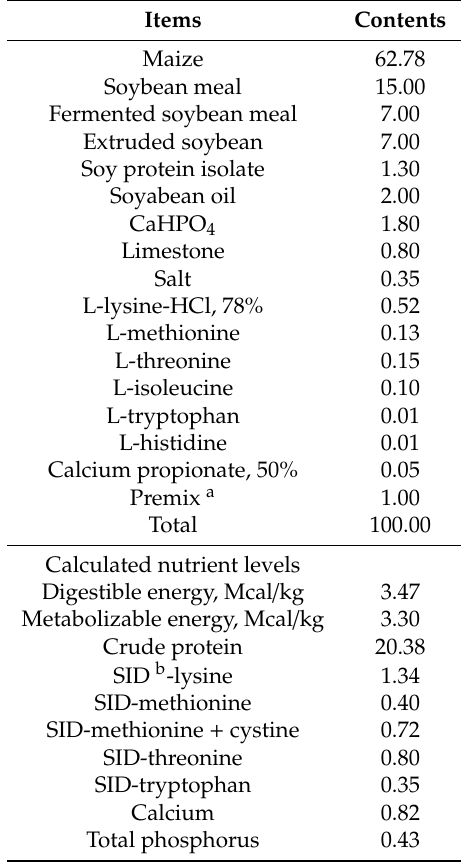
Table 1. Composition and nutrient levels of the diet (%, as-fed basis unless otherwise